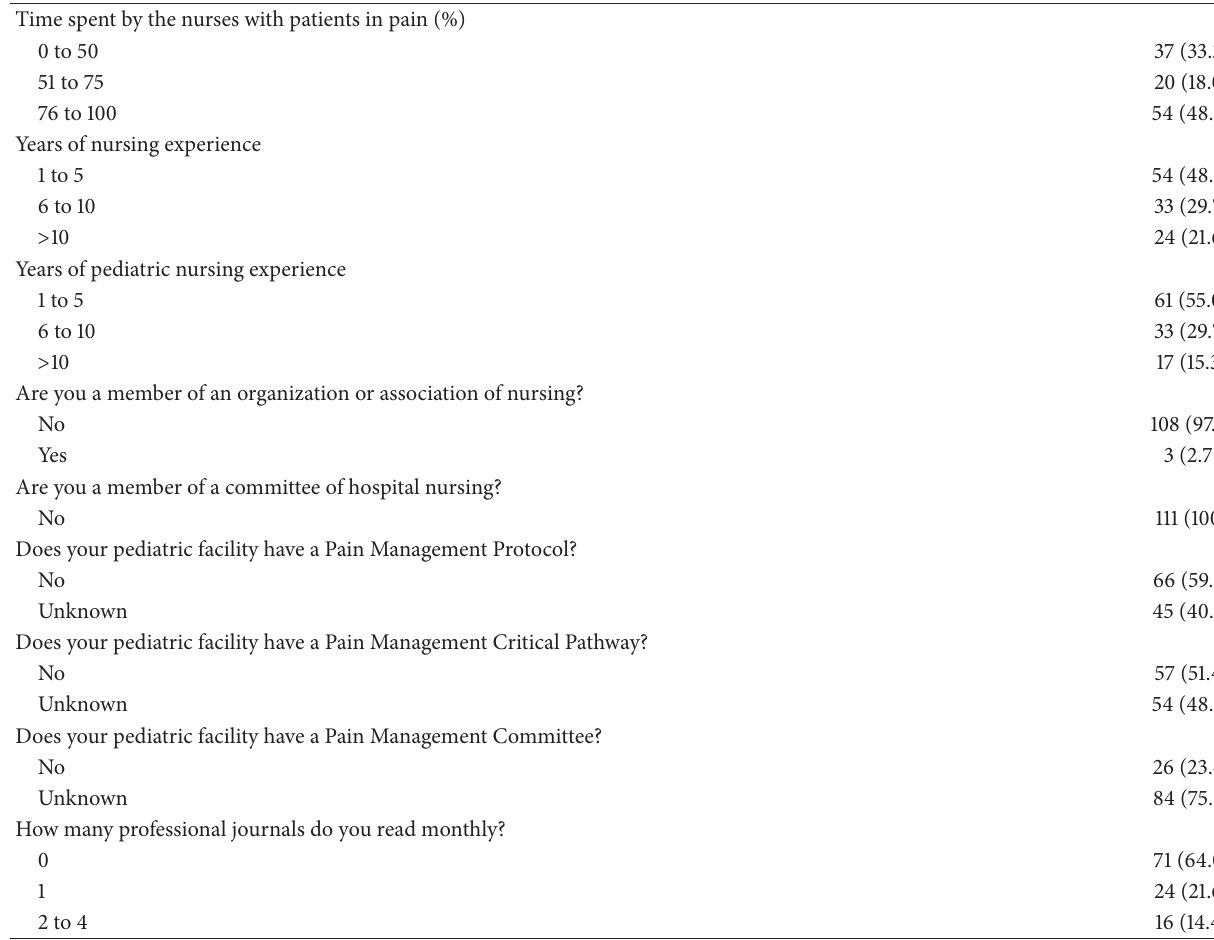
Table 1: Baseline characteristics of hospital pediatric